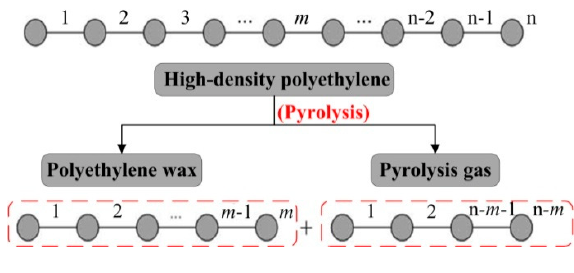
Figure 6. Pyrolysis scheme of random scission for high-density polyethylene (HDPE).